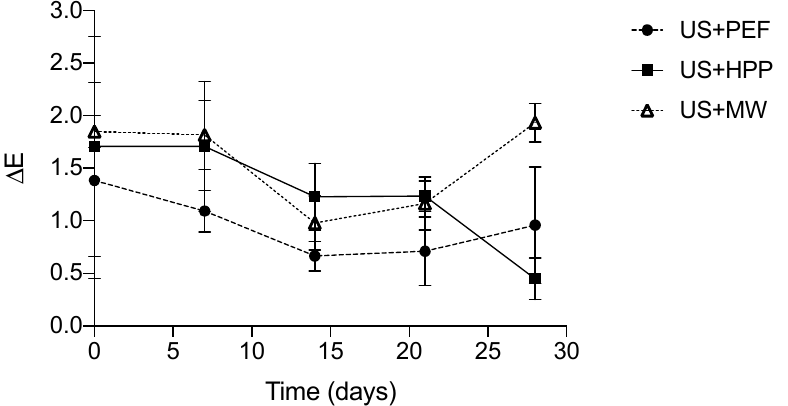
Figure 4. Determinations of the total color difference ( ∆ E ) of milk samples during shelf life compared to commercial milk on each day of measurement.